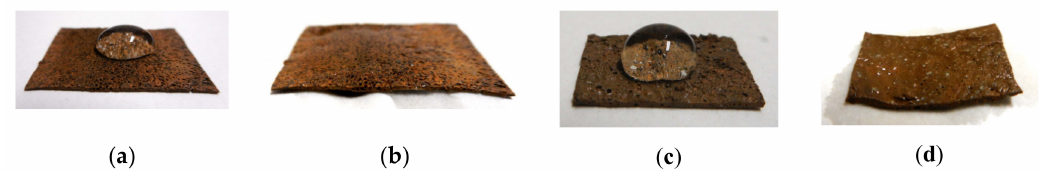
Figure 16. Images of MCF rubber before and after water permeation: ( a ) before permeation (0.75 g MF, 0.5 g TiO 2 , 3 g S-500, 3 g 671A, and 3 g Ni); ( b ) after permeation (0.75 g MF, 0.5 g TiO 2 , 3 g S-500, 3 g 671A, and 3 g Ni); ( c ) before permeation (3 g KF96, 3 g PVA, 0.75 g MF, 0.5 g TiO 2 , 3 g S-500, 3 g 671A, and 3 g Ni); ( d ) after permeation (3 g KF96, 3 g PVA, 0.75 g MF, 0.5 g TiO 2 , 3 g S-500, 3 g 671A, and 3 g